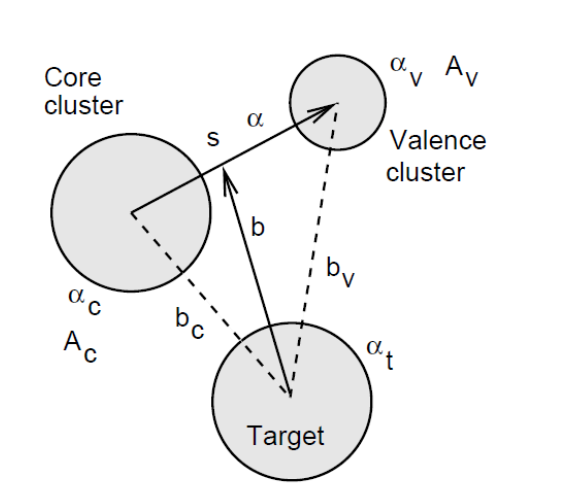
Fig.1: the two-cluster projectile and target